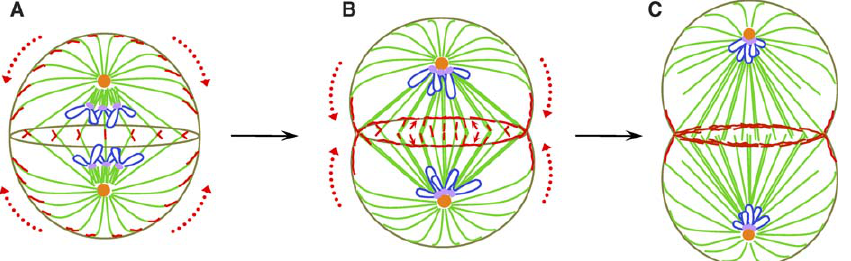
Figure 8. Model for Spindle Microtubule Induction of Contractile Ring Assembly (A) During furrow induction and ingression, dynamic astral microtubules exclude pre-existing actin filaments from the spindle pole (red dotted arrows). (B) This exclusion results in mass migration of filaments to the equator. Meanwhile, overlapping spindle microtubule plus ends at the equator promote de novo assembly of actin aggregates, which are delivered (small red arrows) to the equatorial cortex by splaying bundles of central spindle microtubules. (C) Actin filaments excluded from the polar region coalesce with actin aggregates transported from the central spindle to the equatorial cortex, for assembly of the contractile